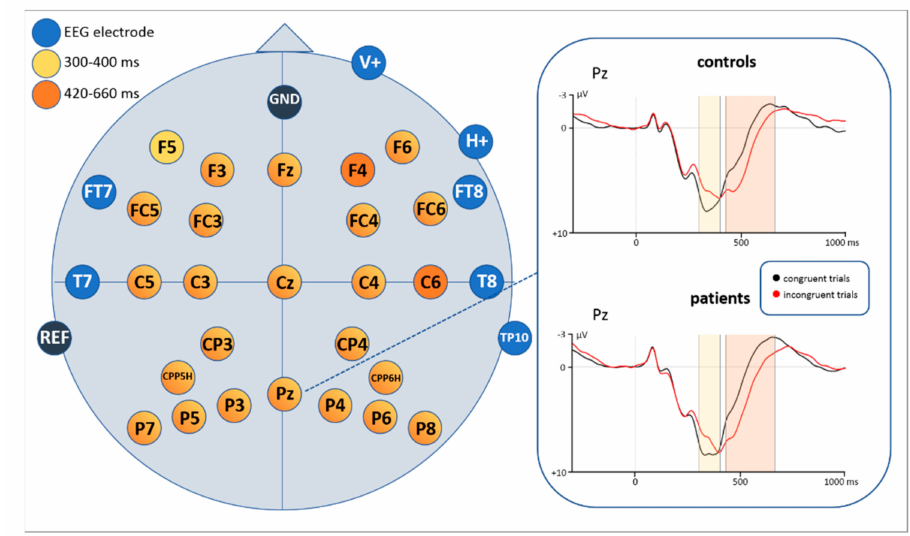
Figure 8. EEG results showing significant channels for the time windows 300–400 ms and 420–660 ms and their inverse effect on an exemplary channel. Negativity is plotted